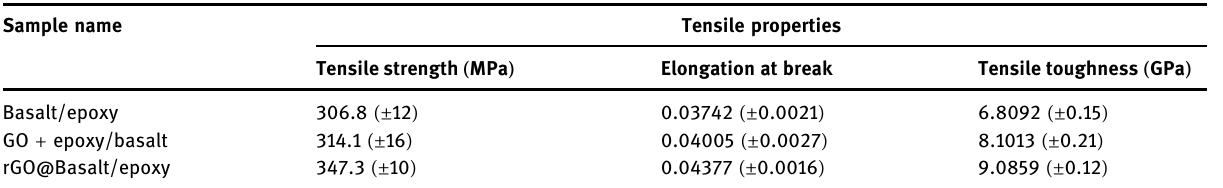
Table 1: Summarized values of tensile strength, elongation at break, and tensile toughness of tensile specimens Sample